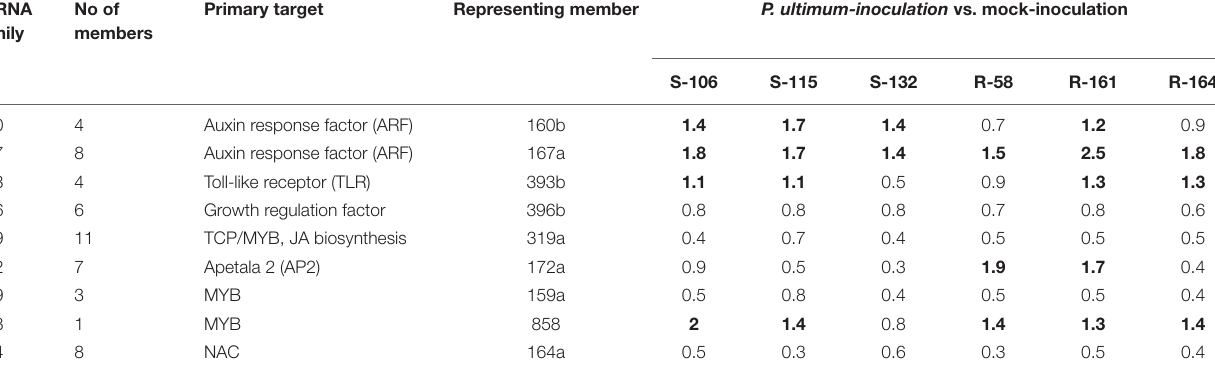
TABLE 3 | Genotype-specific expression patterns for miRNA families regulating hormone signaling and TFs in secondary metabolisms in apple roots in response to Pythium ultimum